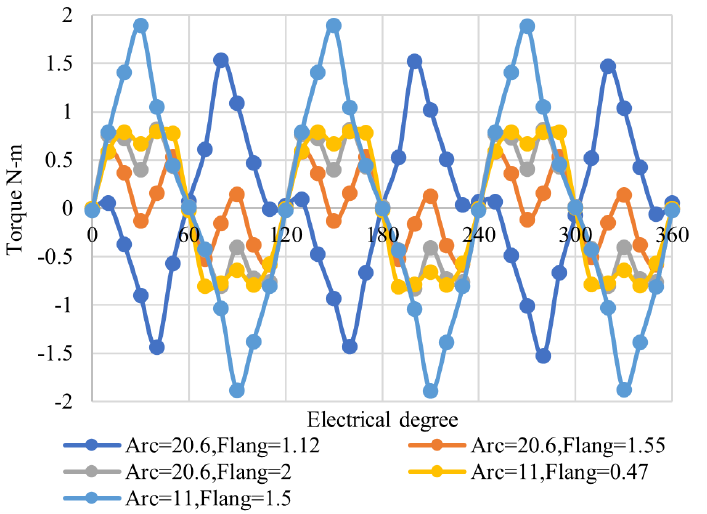
Figure 25. Results of hybrid (arc and flange).